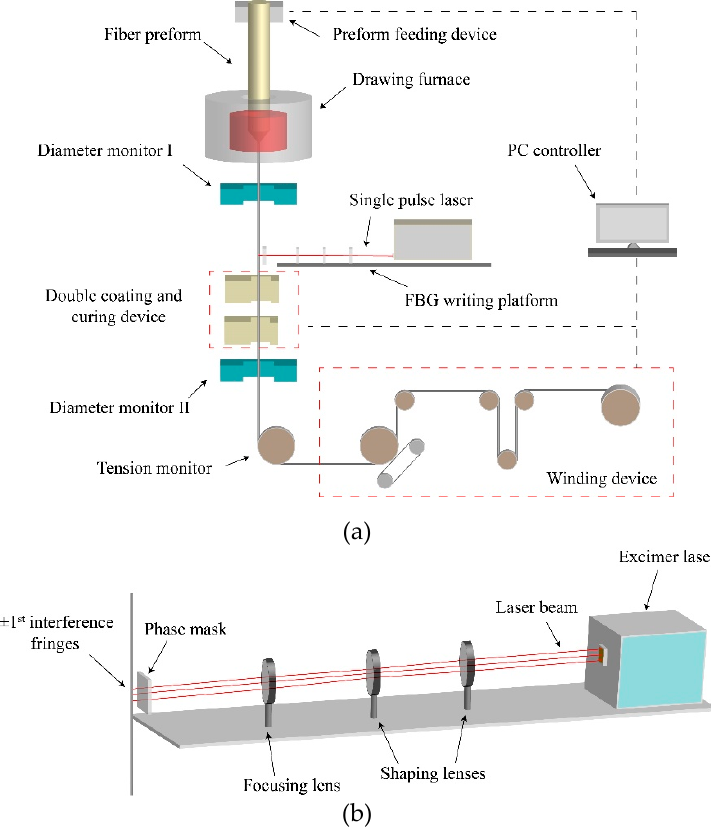
Figure 4. ( a ) Schematic diagram of the FBG online fabrication processes on our customized drawing tower. ( b ) Schematic diagram of the phase mask writing platform.